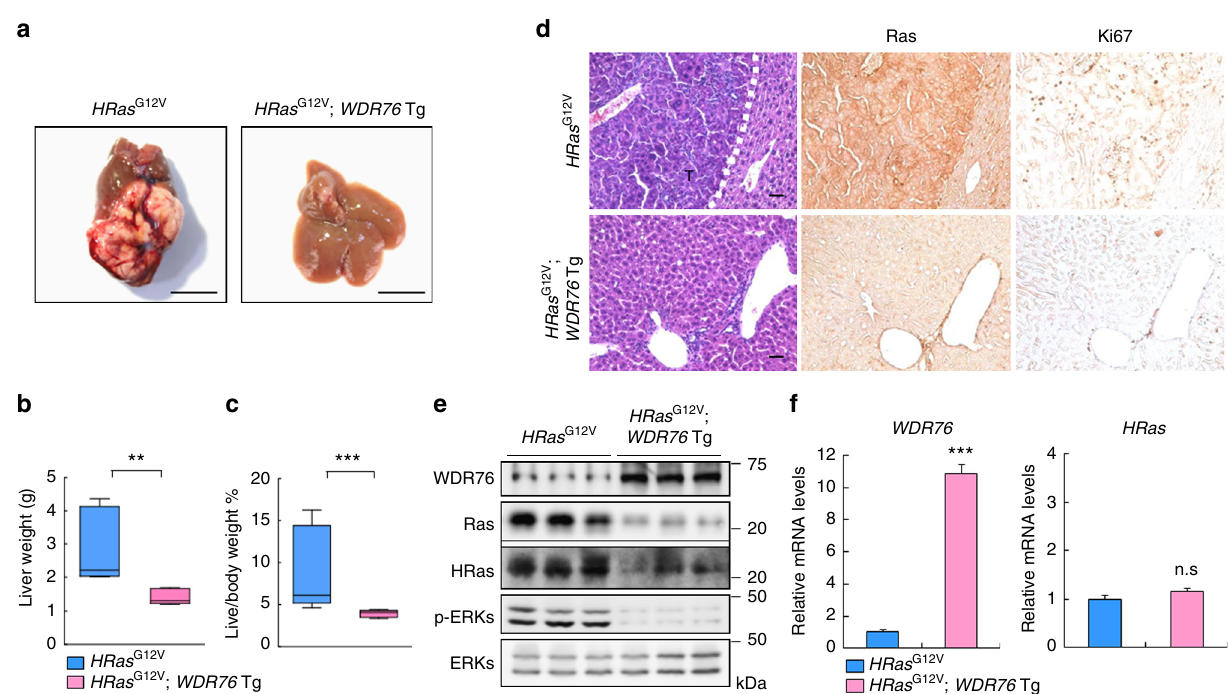
Fig. 5 Liver-speci fi c WDR76 inductions suppresses oncogenic HRas-driven hepatic carcinogenesis. a Representative gross images of livers from HRas G12V and HRas G12V / WDR76 Tg mice. Scale bars, 10 mm. b , c Boxplots show liver weights ( b ), and liver-to-body weight ratios ( c ) ( n = 6 HRas G12V and 6 HRas G12V / WDR76 Tg). Data are presented as the mean ± SEM. Two-sided Student ’ s t test, ** p < 0.01, *** p < 0.001. d – f IHC ( d ), IB ( e ), and quantitative